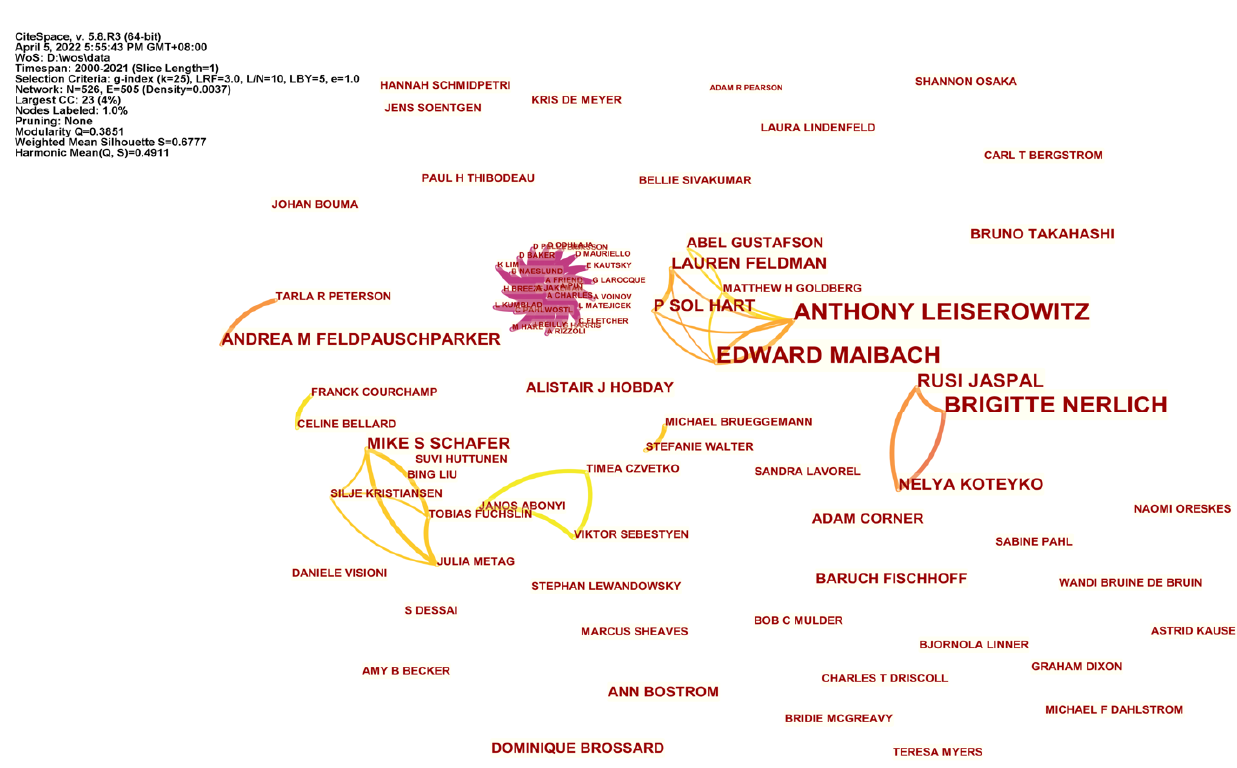
Figure 4. The collaborative network of authors in the field of climate communication research.